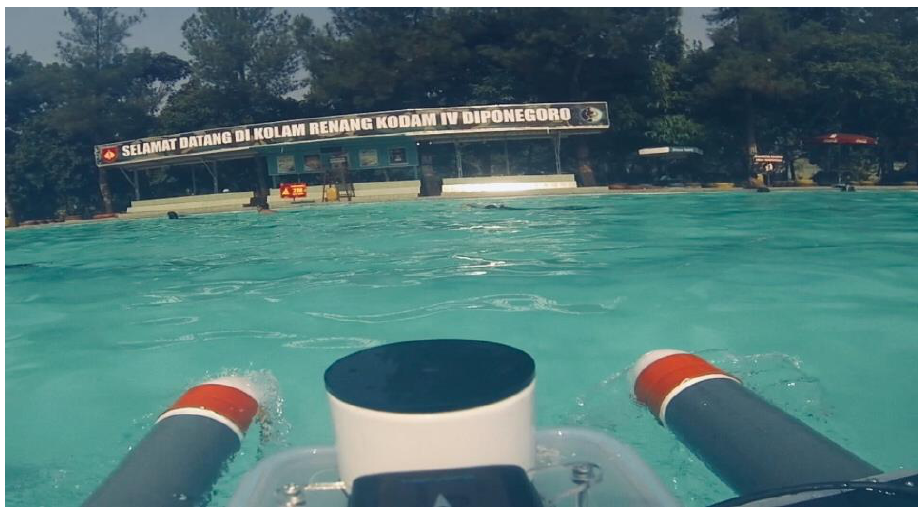
Figure 12. Military camp’s swimming pool.